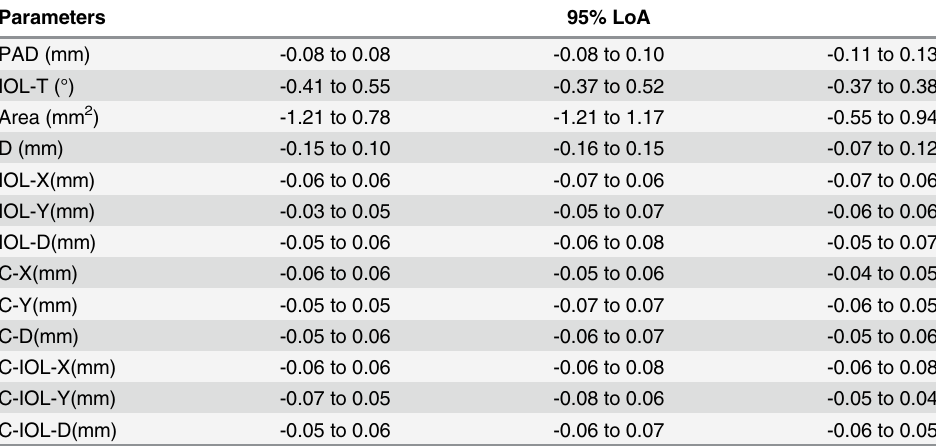
Table 9. The repeatability results of all parameters using Bland-Altman test. Parameters